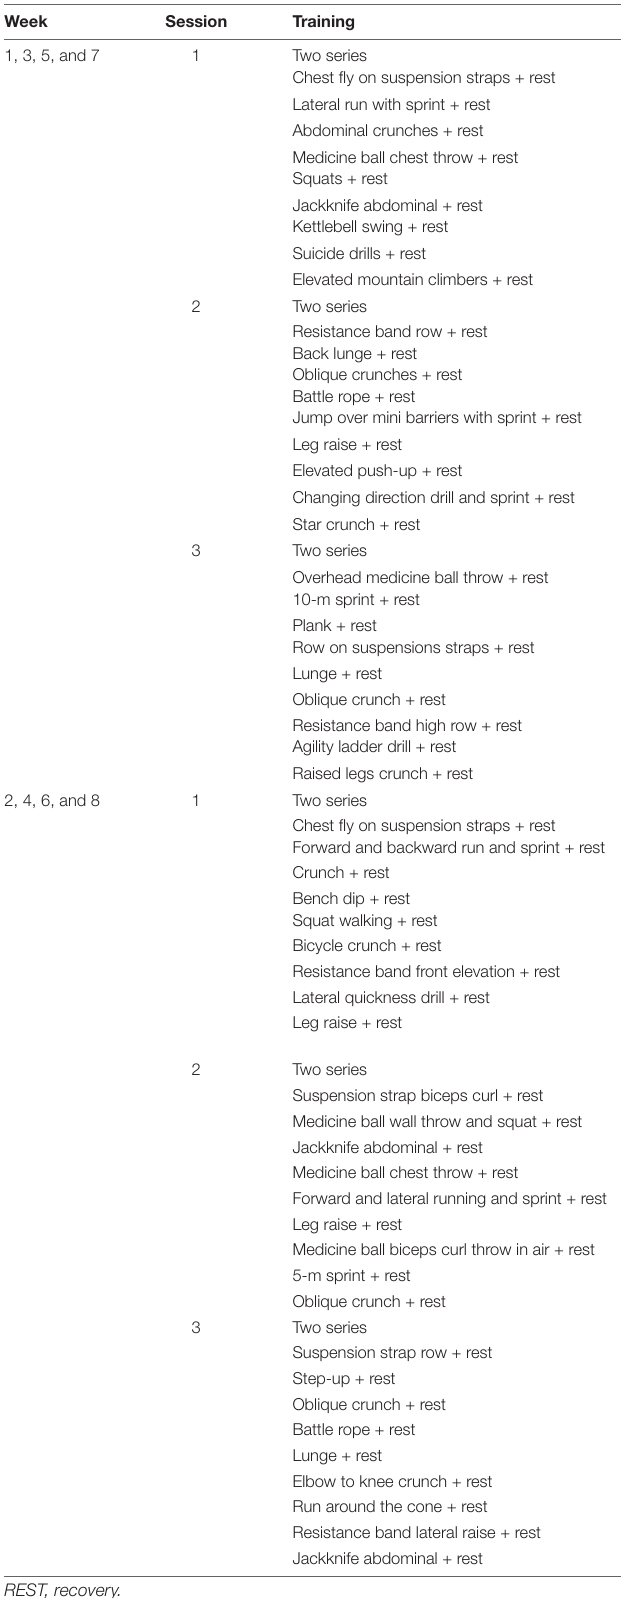
TABLE 1 | Physical training